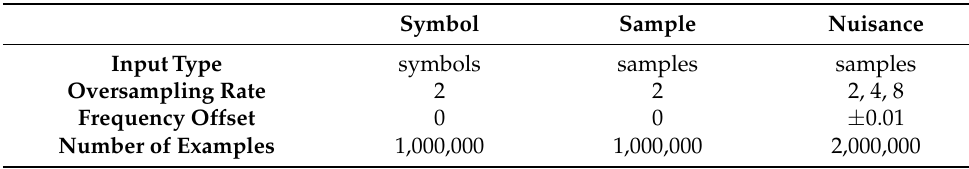
Table 1. RNN input assumptions for each considered spectrum